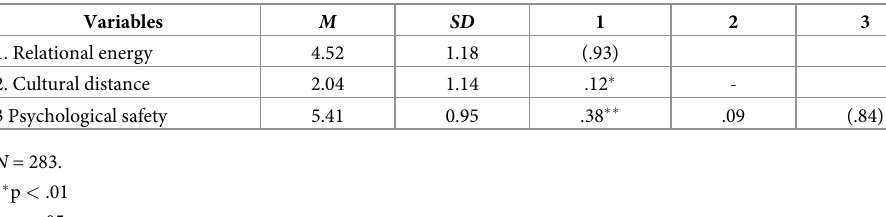
Table 3. Means, standard deviations, and correlations in Study 2.